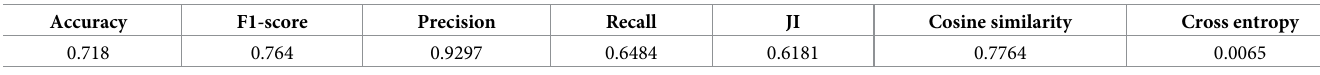
Table 3. Comparison of Impute ð Eq : 1 Þ